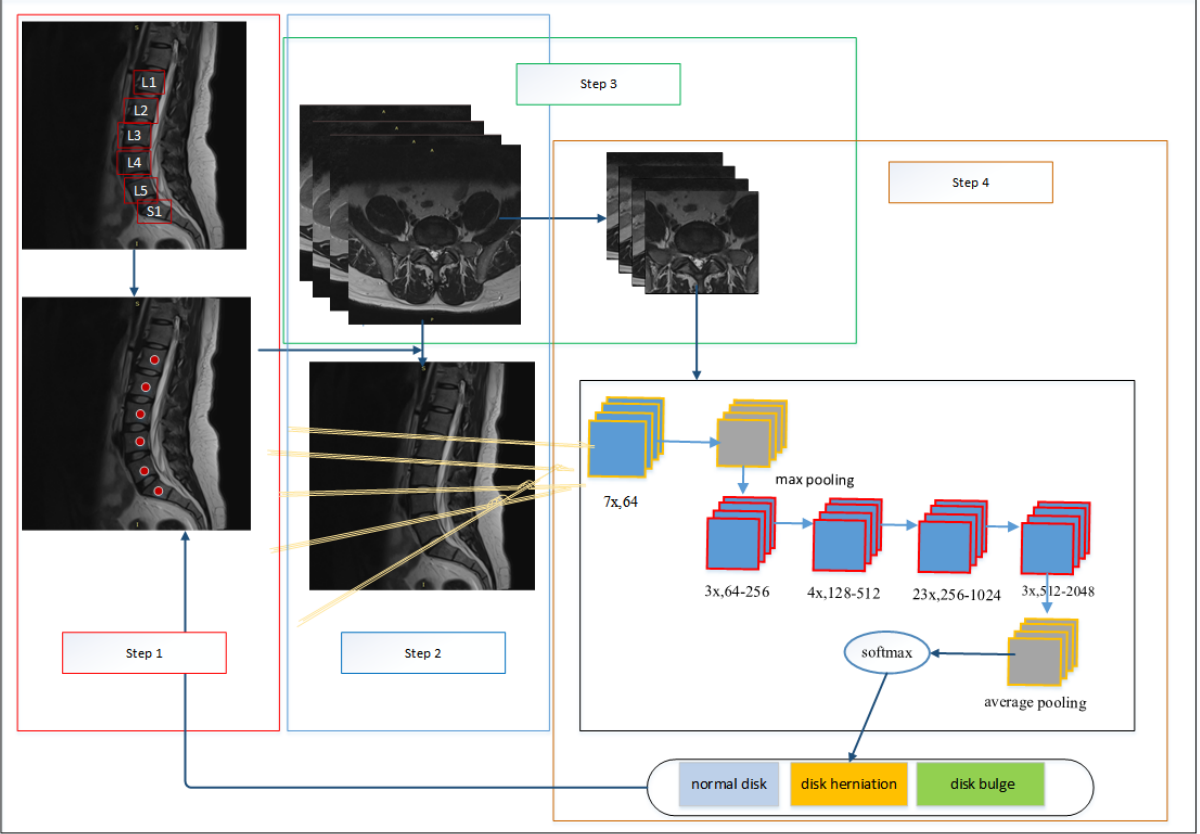
Figure 2. Overall diagnosis system. This system consists of 4 steps. First, vertebral bodies (L1, L2, L3, L4, and L5) in sagittal lumbar magnetic resonance images were automatically located by using the faster R-CNN, and the middle point of each vertebral body was calculated. Second, the axial images were grouped into 5 categories. Each category corresponded to an intervertebral disk (ie, the L1-L2, L2-L3, L3-L4, L4-L5, and L5-S1 intervertebral disks). Third, the intervertebral disk regions of interest in each axial MR image were segmented using the faster R-CNN. Finally, in each category, the region-of-interest images were classified as images of normal disks, disk bulge, and disk herniation using ResNet101. L: lumbar vertebra; R-CNN: region-based convolutional neural network; S: